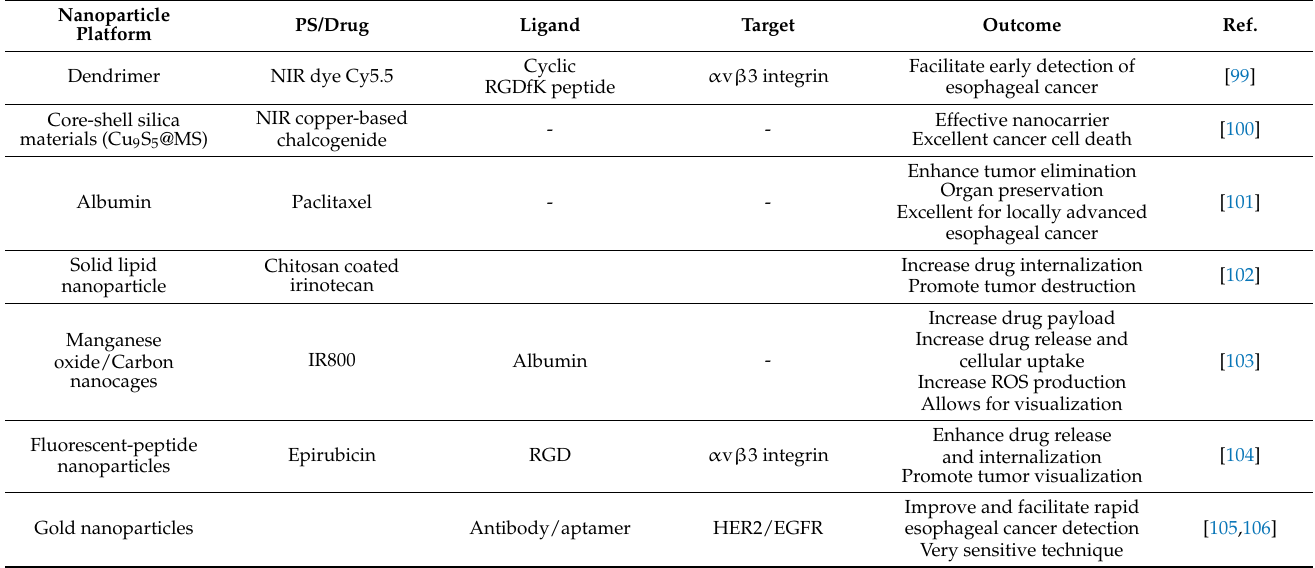
Table 4. Functionalized nanomedicine for targeted PDD and PDT of esophageal